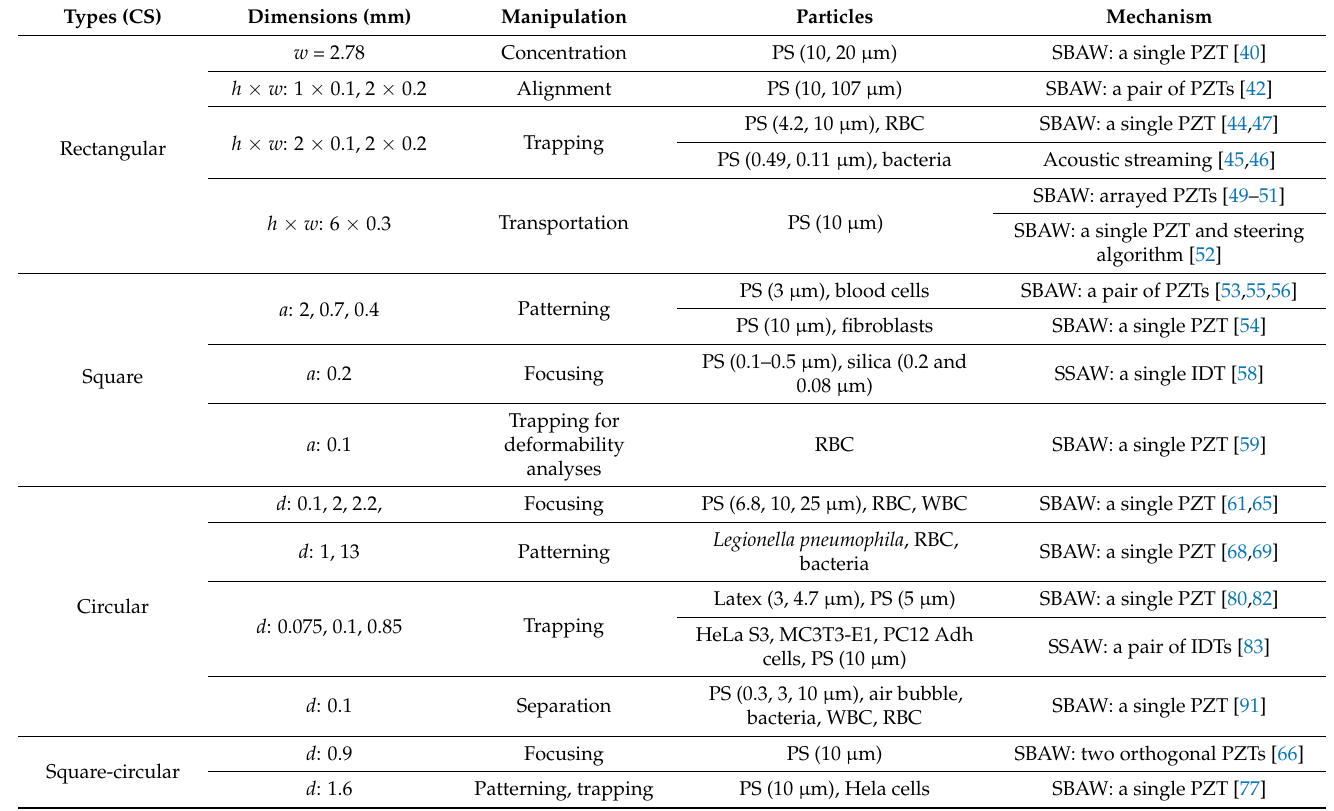
Table 1. Summary of the use of glass capillaries for ultrasonic particle